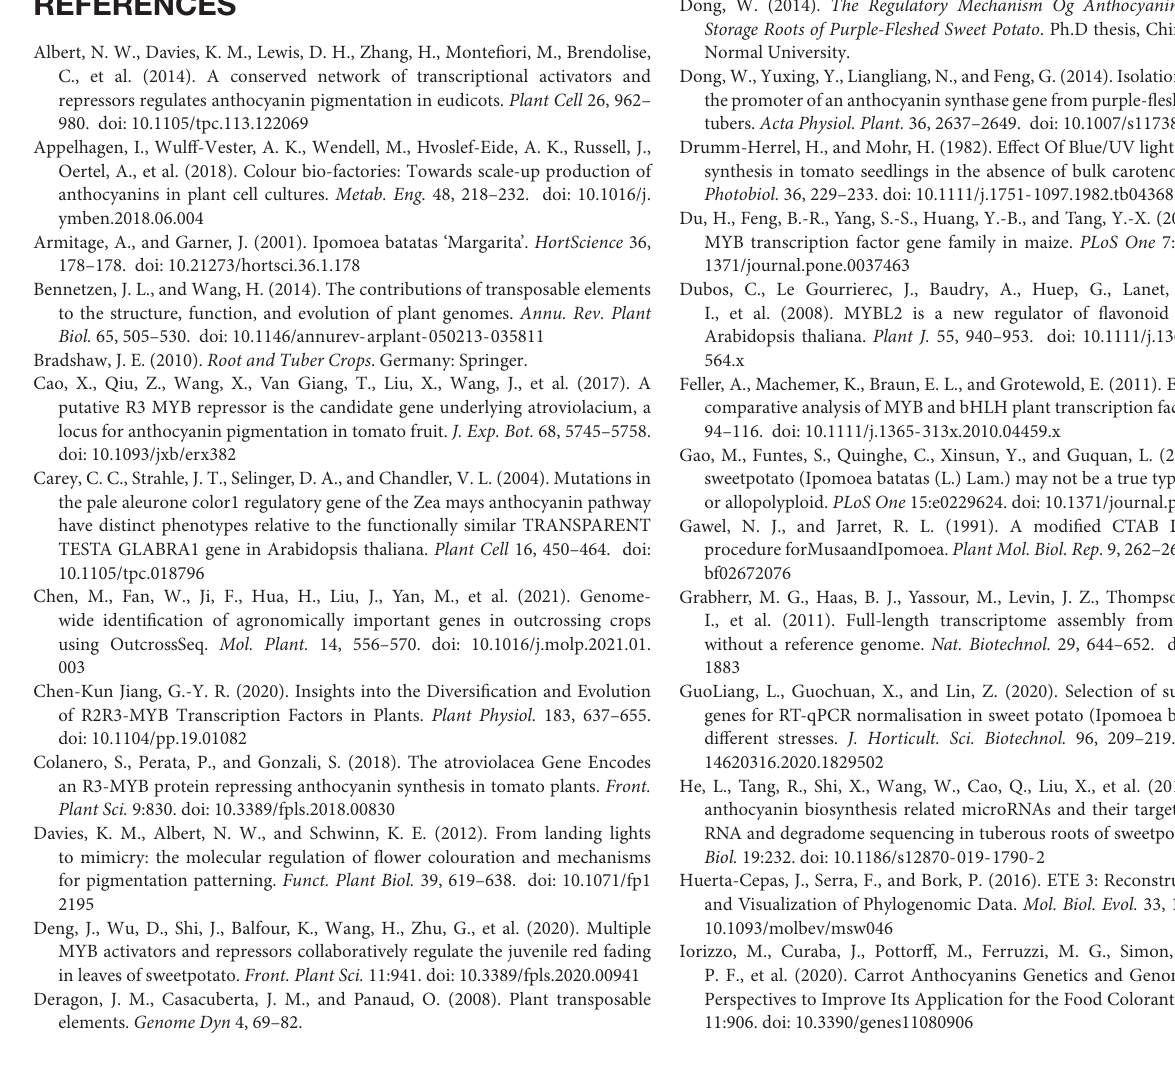
Supplementary Figure 6 | Pearson’s correlation coefficient between anthocyanin concentration and MYBs expression in leaf and storage root. Supplementary Figure 7 | Pearson’s correlation coefficient between anthocyanin concentration and MYBs expression in leaf and storage root that were screened Supplementary Figure 8 | The retrotransposon sequence that cloned from the 3 (cid:48) flanking sequence of IbMYB1-1 . Supplementary Figure 9 | Transcript sequence of IbMYB2s . (A) IbMYB1 and IbMYB2s were cloned from the cDNA of leaves by RT-PCR. (B) Alignment of